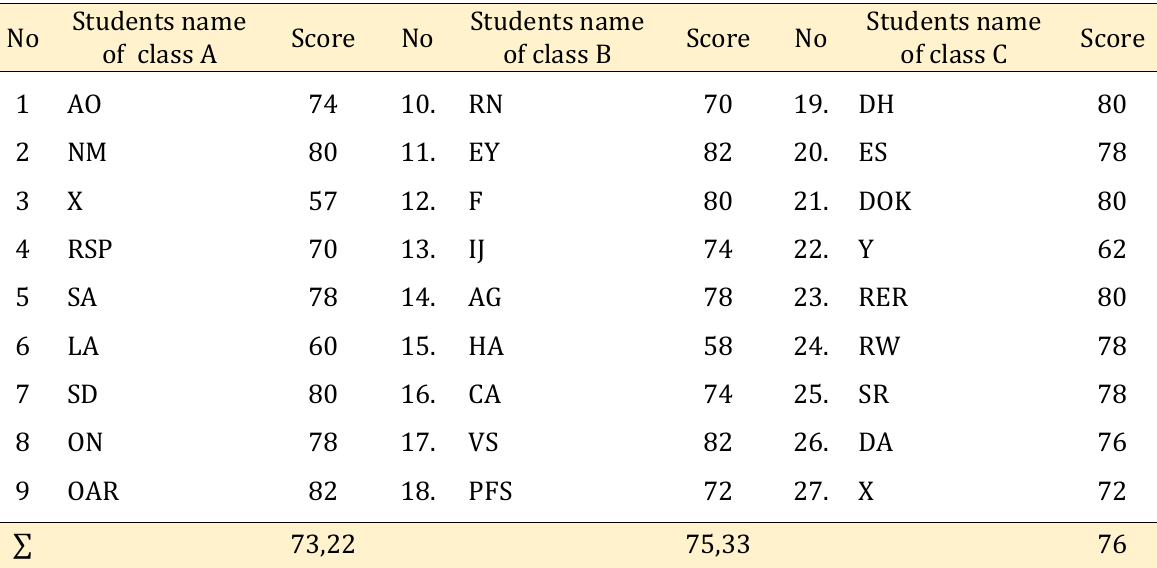
Table 3. The Score of Critical Thinking by Reading Test